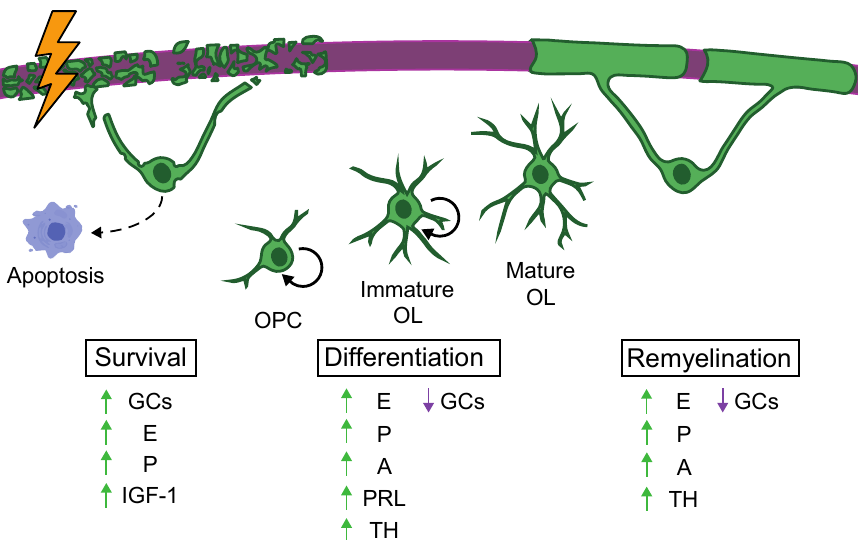
Figure 1. After an insult that leads to myelin degradation, oligodendrocyte (OL) survival, oligodendrogenesis, and remyelination are differentially affected by various classes of hormones. Green arrow = promote, Purple arrow = downregulate. GCs = glucocorticoids, E = estrogens, P = progestogens, A = androgens, IGF-1 = insulin-like growth factor-1, PRL = prolactin, TH = thyroid hormones.